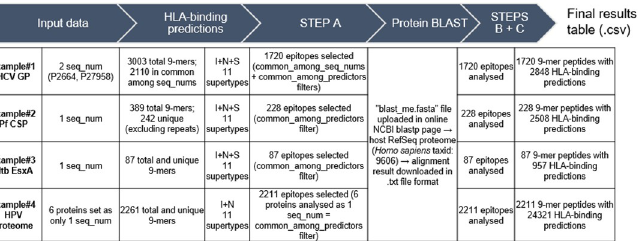
Fig 1. Results for HLA-class I T-cell epitope selection with SILVI on the 4 example proteins. I, IEDB MHC-I binding (consensus); N, NetMHCpan; S, SYFPEITHI.